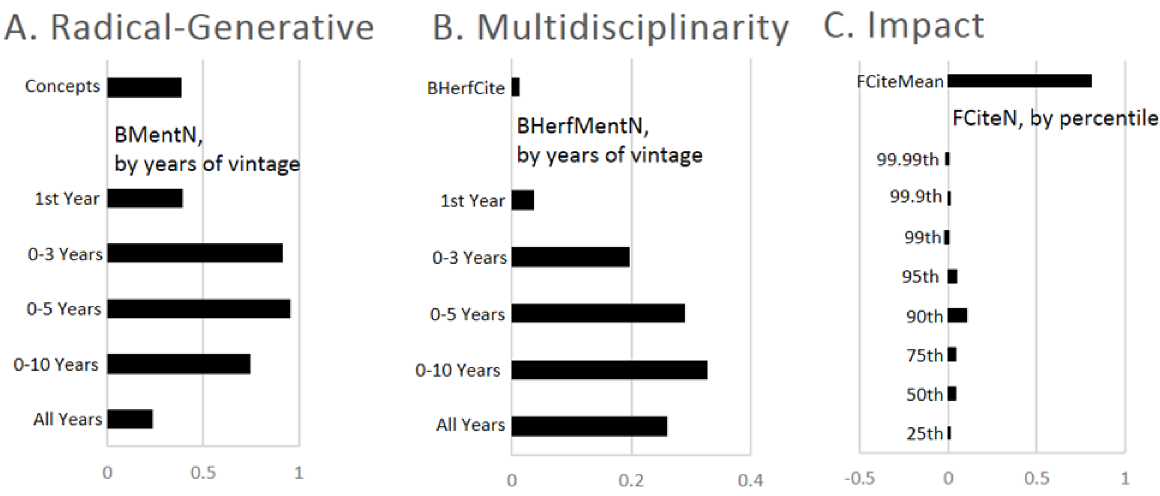
Fig 2. Factor loadings from a factor analysis results for three of the seven aspects.